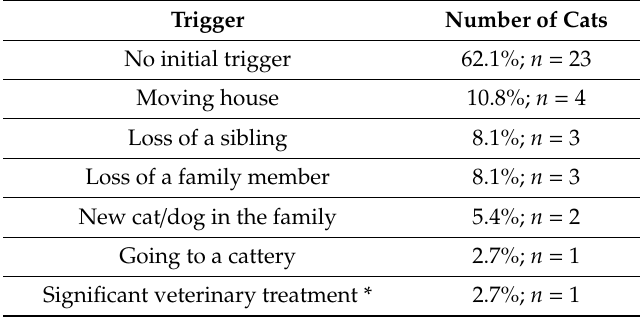
Table 2. Initial trigger event that led to increased vocalisation as reported by the